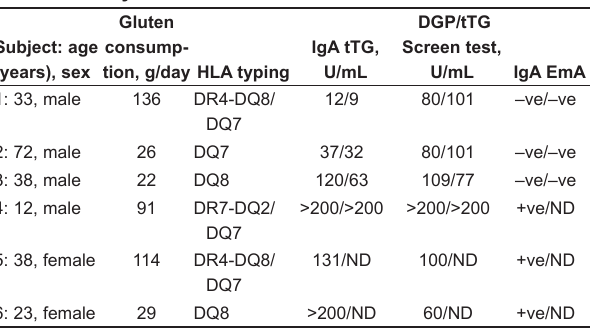
Table 2 Individual estimation of gluten consumption, genetic human leukocyte antigen (Hla) typing and serological status in patients considered to have gluten autoimmunity* or celiac disease †